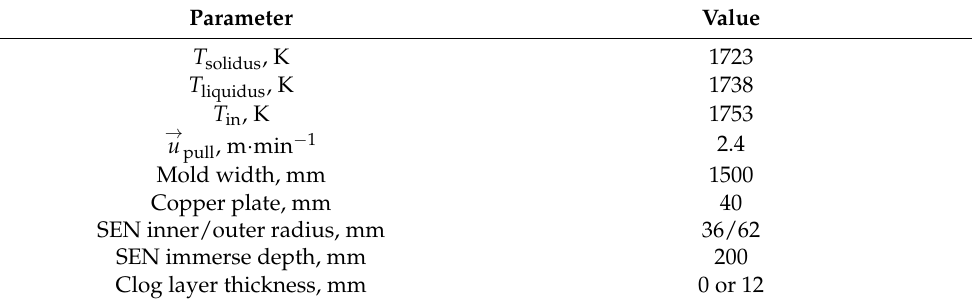
Table 2. Simulated process